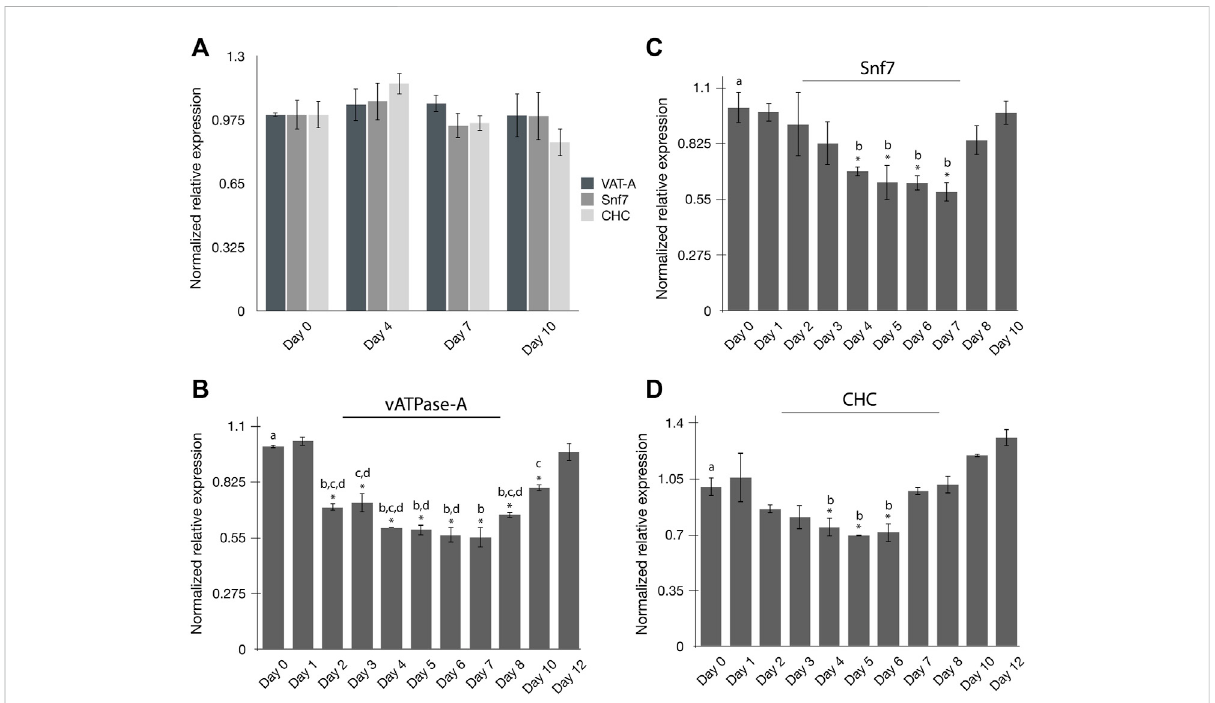
FIGURE 2 Persistence of RNAi mediated gene silencing in potato psyllids (A – D) . (A) Endogenous expression of “ Candidatus Liberibacter solanacearum ” - infected PoP vATPase-A , Snf, and CHC genes at day 0, 4, 7 and 10; (B – D) Gene expression for candidate genes was normalized to the respective expression level corresponding to that on day zero (0). Time-course study of relative normalized expression of vATPase subunit-A (B) , Snf7 (C) , and CHC (D) genes for CLso-infected PoP teneral adults 10-day post-IAP. On day zero (0), psyllids were given an ingestion-access period (IAP) on dsRNA for each respective gene target or the luciferase non-target control (Luc) at 100 ng/ μ L, 200 μ L. On day two (48-h), the dsRNA-sucrose solution was replaced with 20% (w/v) sucrose solution (dsRNA-free). Gene expression was determined by real-time, quantitative reverse transcriptase-polymerase chain reaction ampli fi cation, and the results were compared to gene expression levels corresponding to day 0. The asterisk (*) indicates differences in gene expression between day 0 and each respective day for which expression was analyzed, based on the Student ’ st-test( p -value < 0.0.5).Byconvention,Tukey ’ sHSDtestwasappliedtogroupsexhibitingsigni fi cantdifferencesrelativetoday0expression. Thelowercaselettersa-dindicatedifferentsigni fi cantgroupsdeterminedbyTukey ’ sHSDtest( p